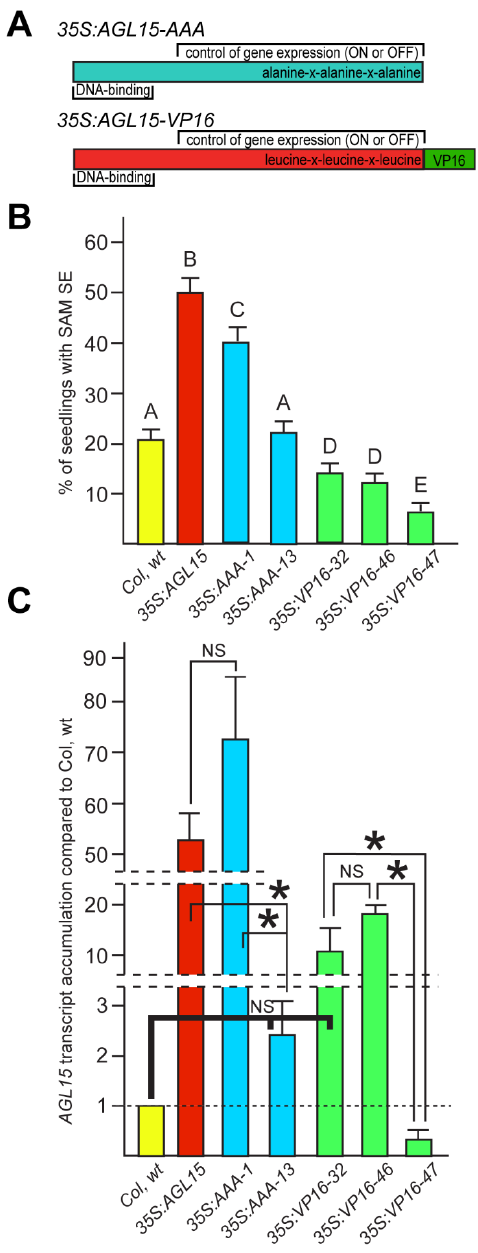
Figure 1. Shoot apical meristem somatic embryo (SAM SE) and transcript accumulation from different AGL15 transgenes. ( A ) Forms of the 35:AGL15 transgene predicted to remove AGAMOUS-like 15 (AGL15)’s repressive activity are shown. In the 35S:AGL15-AAA (35S:AAA) , the codons for the leucine in the ethylene-responsive element binding factor-associated amphiphilic repression (EAR) motif are altered to encode alanines. In the 35S:AGL15-VP16 (35S:VP16 ) transgene, sequences encoding a strong transcriptional activation domain, VP16, are fused at the carboxyl-terminal end of AGL15. ( B ) SAM SE production by the different AGL15 transgenes compared to Col wild type (wt). Means and standard error of the mean for at least four biological replicates of the experiment are shown. Different letters indicate significant difference in SAM SE production between the different genotypes at p < 0.05 using a Student’s t -test. ( C ) AGL15 transcript accumulation in the different transgenic lines compared to Col wt (set to 1) in 10–12 d SAM SE tissue. Data shown are the means of at least two biological replicates of the experiment. * indicates a significant difference at p < 0.05. Only nonsignificant (NS) changes are noted for the transgenic lines compared to Col wt. Please note the breaks in the